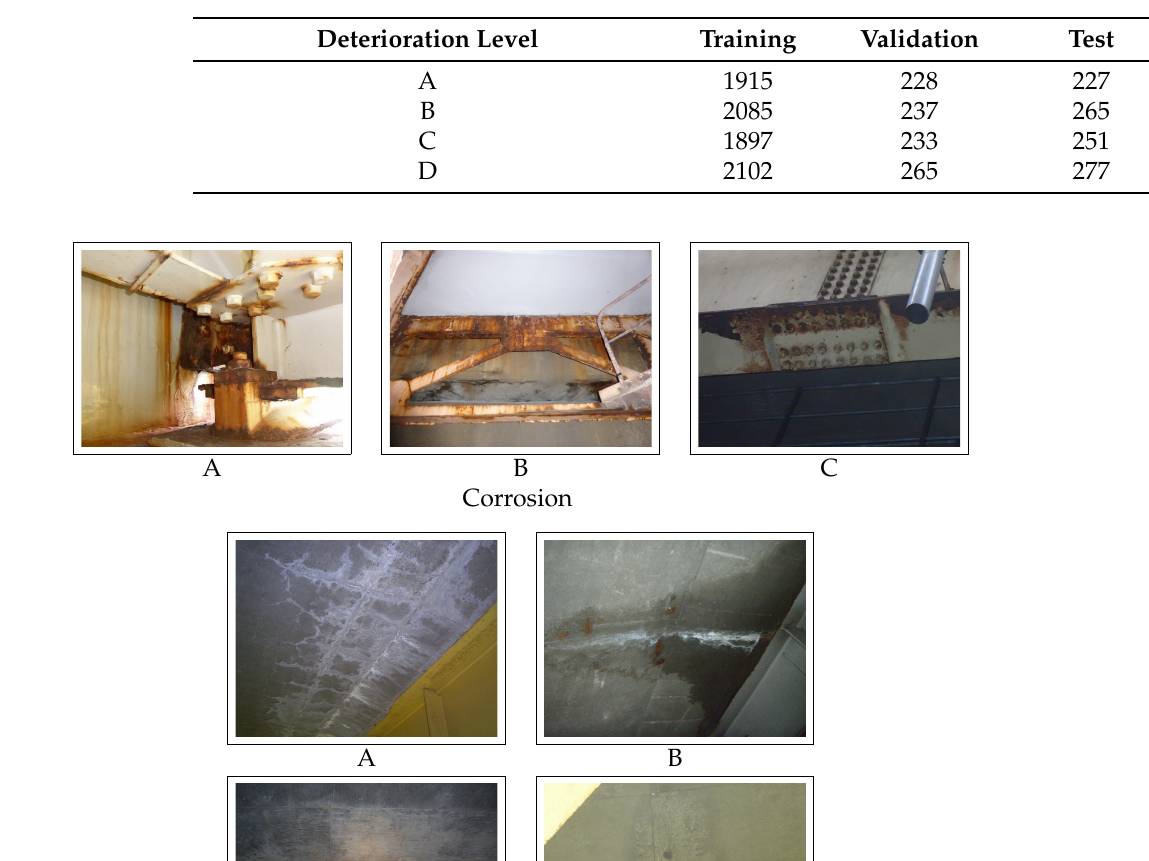
Table 3. Numbers of the distress images of crack used in the experiment.